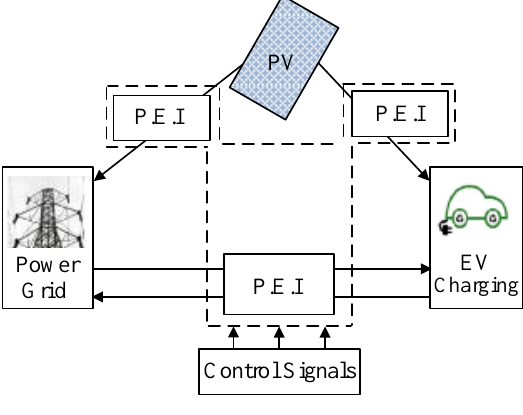
Figure 1. Block diagram of the